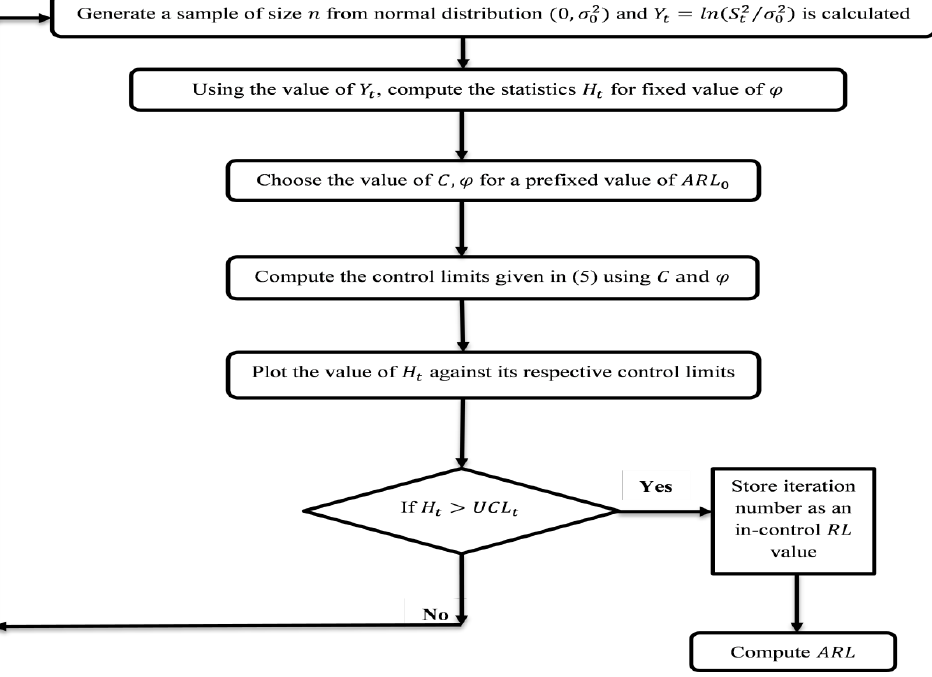
Figure 1. Flow chart procedure for the proposed chart.